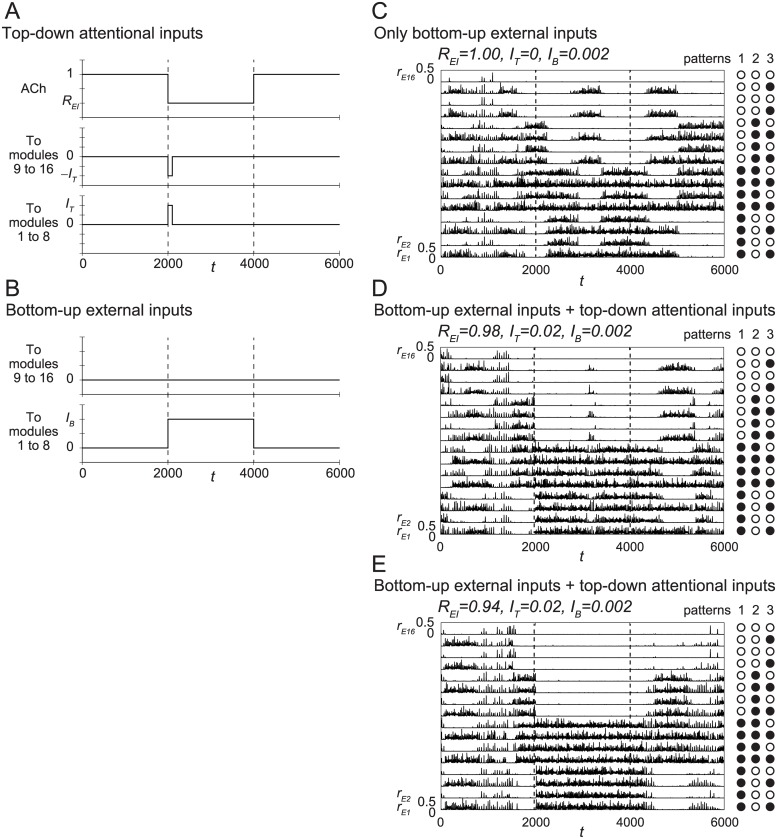
Responses of the network to inputs.(A, B) Inputs to the network. (A) Top-down attentional inputs composed of disinhibition of synapses caused by ACh and the glutamatergic spike volleys, which are controlled by REI and IT, respectively. (B) Bottom-up inputs are controlled by IB. (C-E) Attention-dependent changes in dynamics of the network. (C) Dynamics only with the bottom-up inputs for REI = 1, IT = 0, and IB = 0.002. (D, E) Dynamics with both the top-down attentional inputs and the bottom-up inputs for (D) REI = 0.98, IT = 0.02, and IB = 0.002 and (E) REI = 0.94, IT = 0.02, and IB = 0.002.